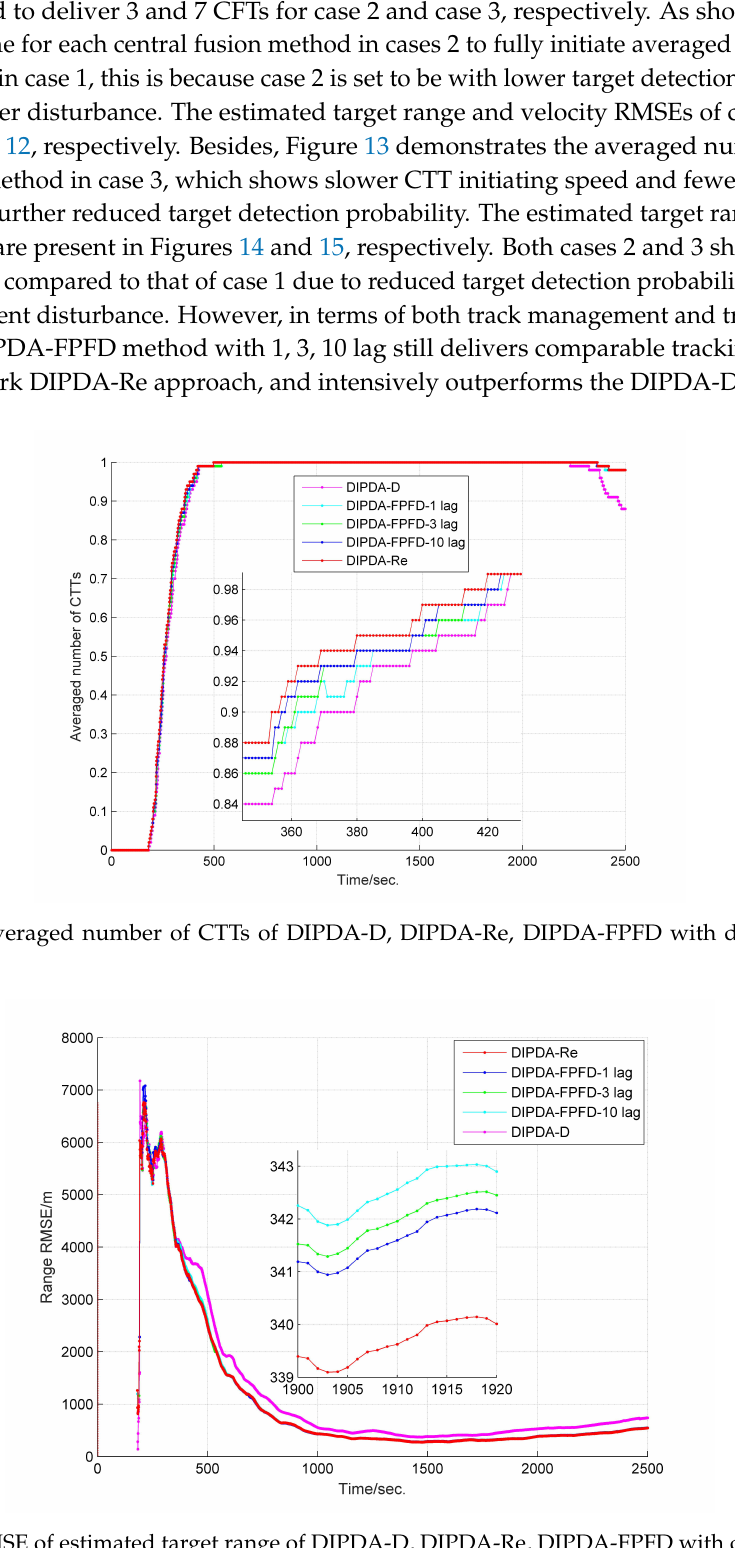
Figure 11. RMSE of estimated target range of DIPDA-D, DIPDA-Re, DIPDA-FPFD with different lags (case